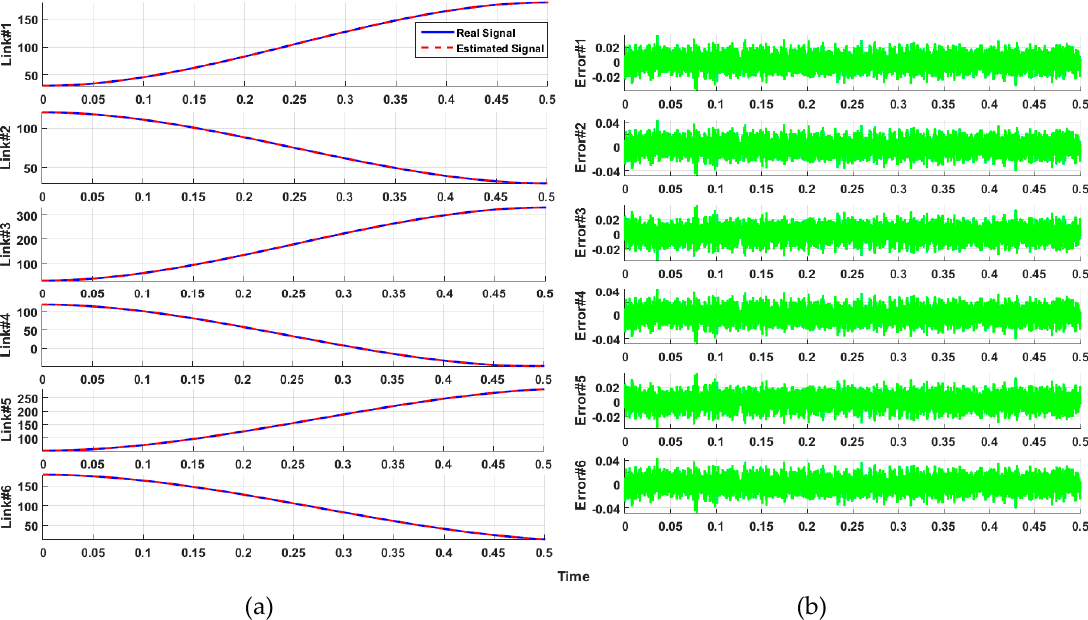
Figure 2. Autoregressive exogenous input (ARX)–Laguerre orthonormal method for robot identification/estimation in the normal condition: ( a ) desired and estimation output position and ( b ) error (residual signal).